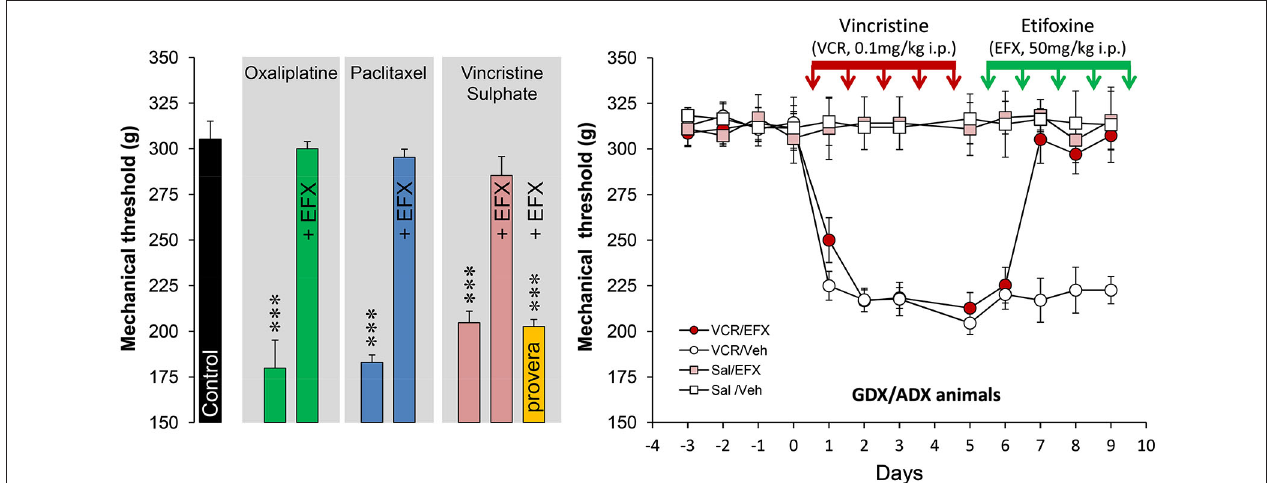
injections with etifoxine (EFX, 50 mg/kg i.p.). EFX analgesia was abolished in animals pre-treated for 1 week before VCR with depo-provera (orange bar; inhibitor of 3 α -HSOR, five daily injections of 5 mg/kg s.c.). Graph on the right illustrates the time course of mechanical threshold in gonadectomized/adrenalectomized (GDX/ADX) rats, submitted to VCR chemotherapy (or saline) and treated for their mechanical allodynia with EFX (or vehicle). Note that EFX analgesia persisted even in the absence of peripheral source of steroids. Abbreviations: EFX: etifoxine, Sal: saline, VCR: vincristine, Veh: vehicle. Adapted from Aouad et al.